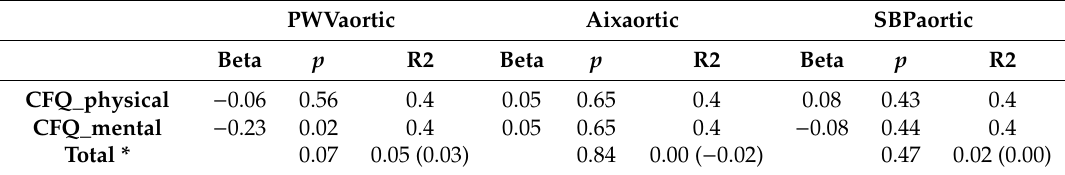
Table 4. Relationship between results of FSS and FIS and arterial sti ff ness parameters in the linear regression analysis. PWVaortic Aixaortic SBPaortic Beta